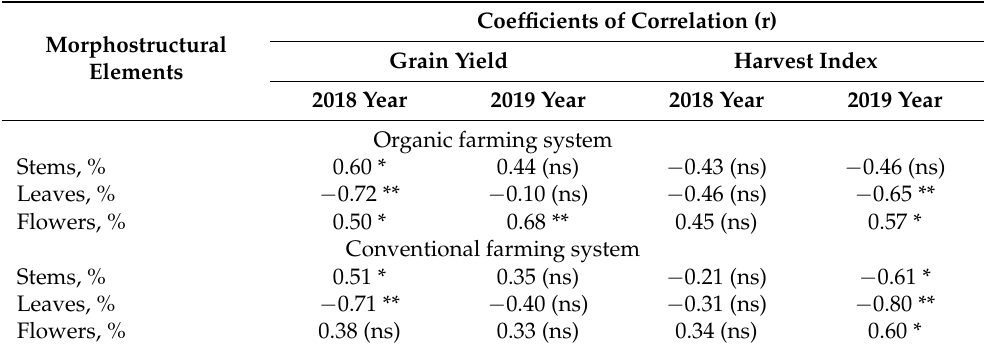
Table 4. Correlation coefficients (r) between relative proportions of morphological elements and grain yield and harvest index each year ( n =